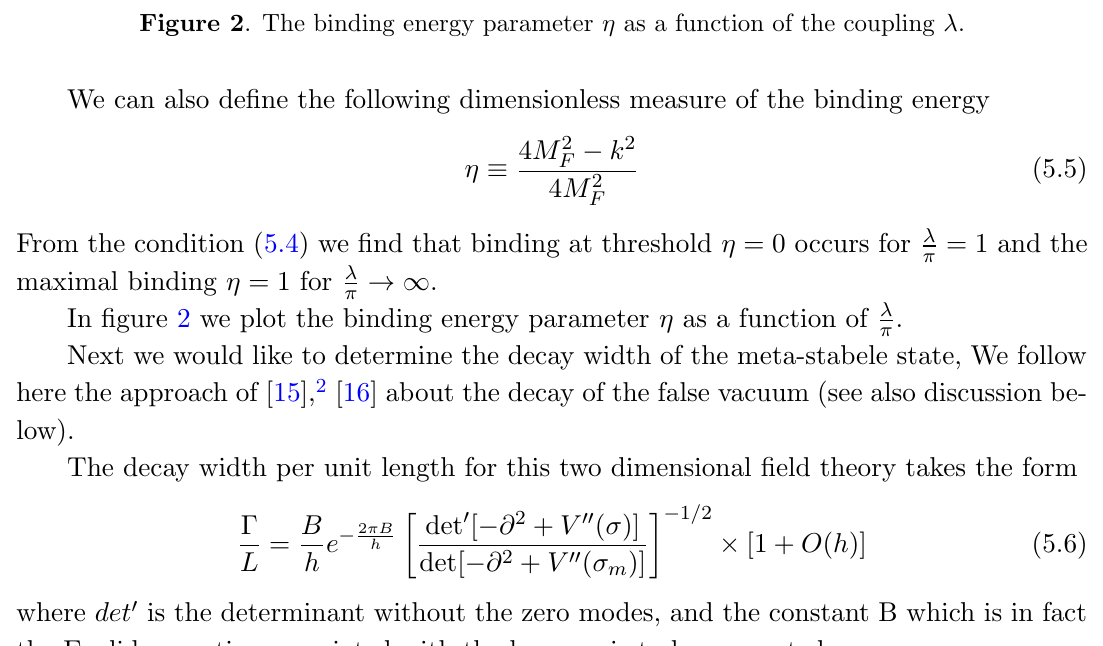
Figure 2 . The binding energy parameter (cid:17) as a function of the coupling (cid:21)